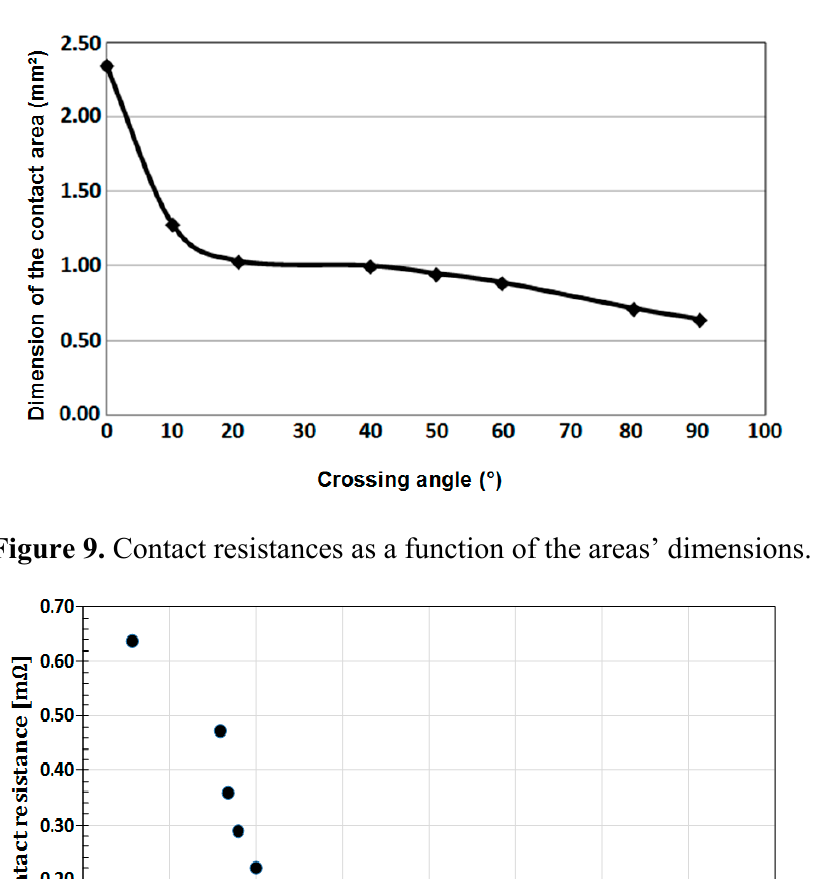
Figure 8. Dimensions of the contact zone as a function of crossing angle (compressive force 480 N).